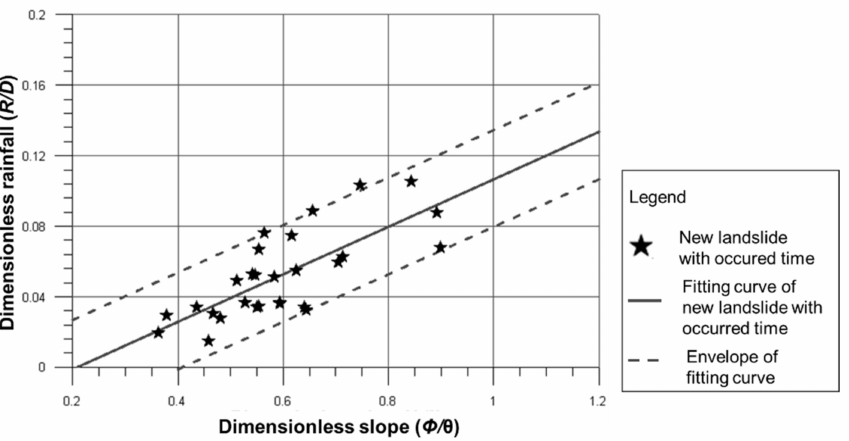
Figure 9. Relationship between dimensionless rainfall and dimensionless slope for new landslides with time of occurrence.